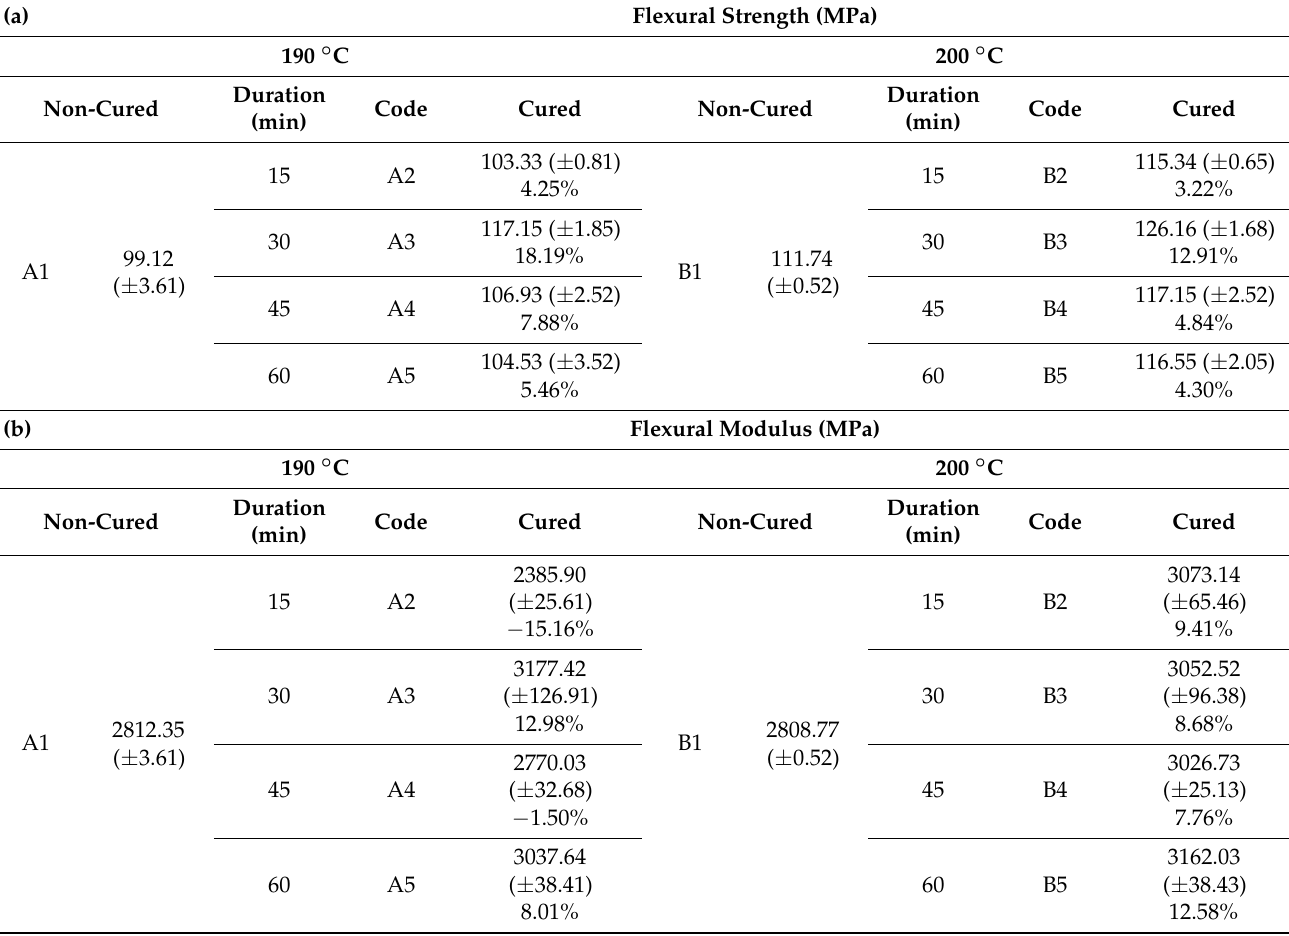
Table 4. ( a ) Flexural strength and ( b ) flexural modulus of PLA parts exposed to post-UV